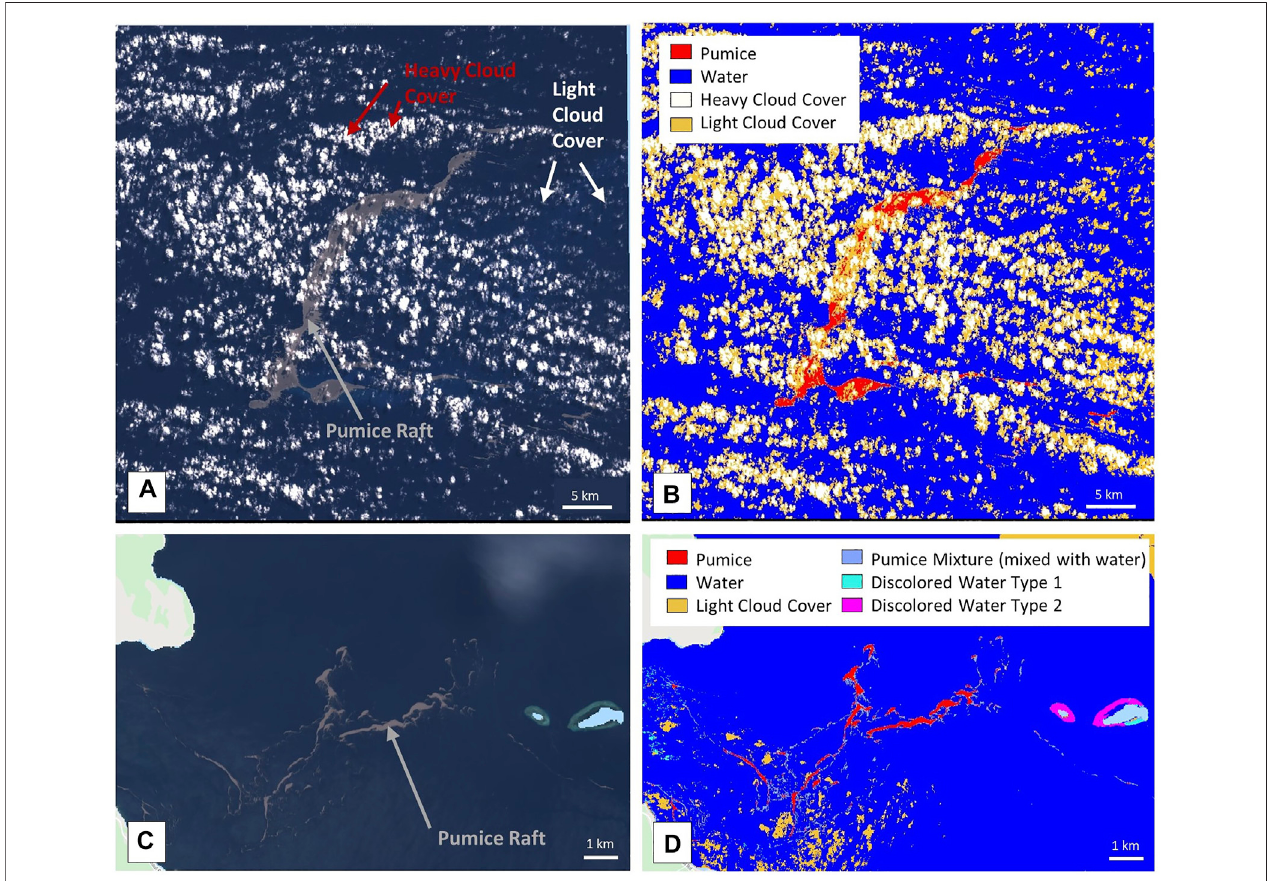
FIGURE 2 | (A) Land-masked RGB image of Tonga region on 08/11/2019 (B) Classi fi ed image of Tonga region on 08/11/2019 (C) Land-masked RGB image of Rabaul on 04/20/2020 (D) Land-masked classi fi ed image of Rabaul on 04/20/2020.